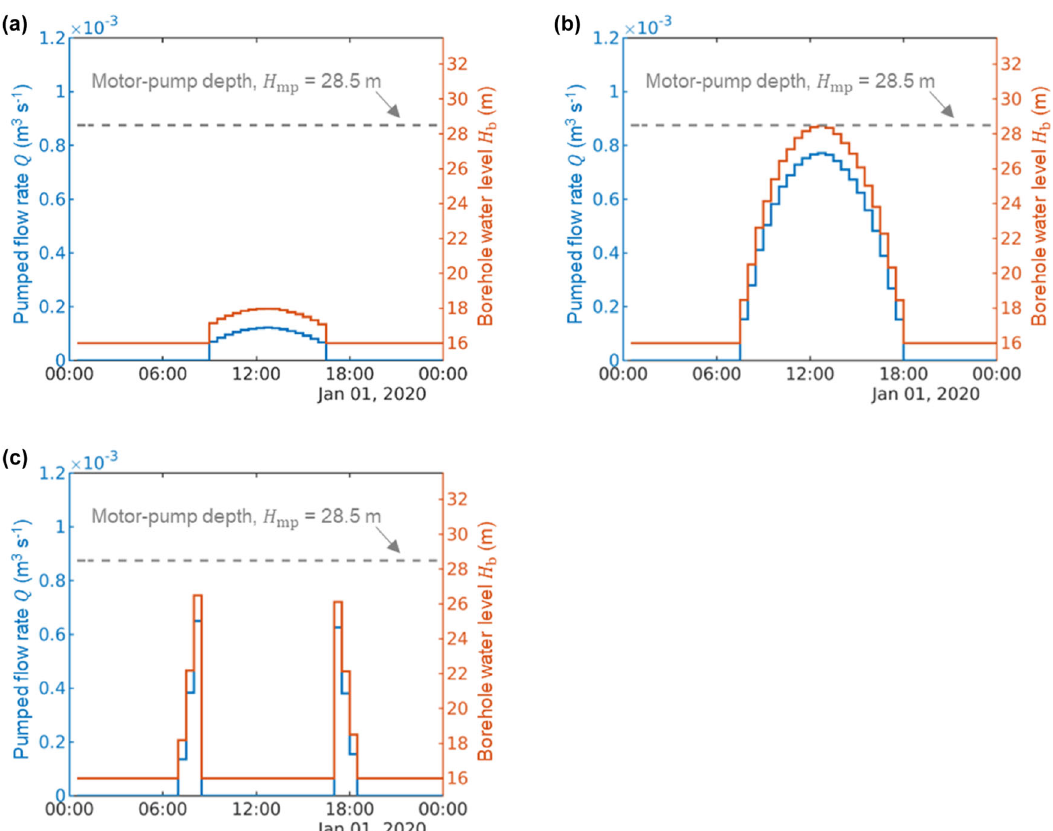
Fig. 4 Evolution of the pumped fl ow rate and of the borehole water depth, at the location 6.2° (lat) & − 5.2° (lon), for three PVWPS sizes. a P p = 100 W p , b P p = 1000 W p , c P p = 3000 W p . The pumped fl ow rate is plotted in solid blue, the borehole water level in solid orange and the motor-pump depth with a dashed gray